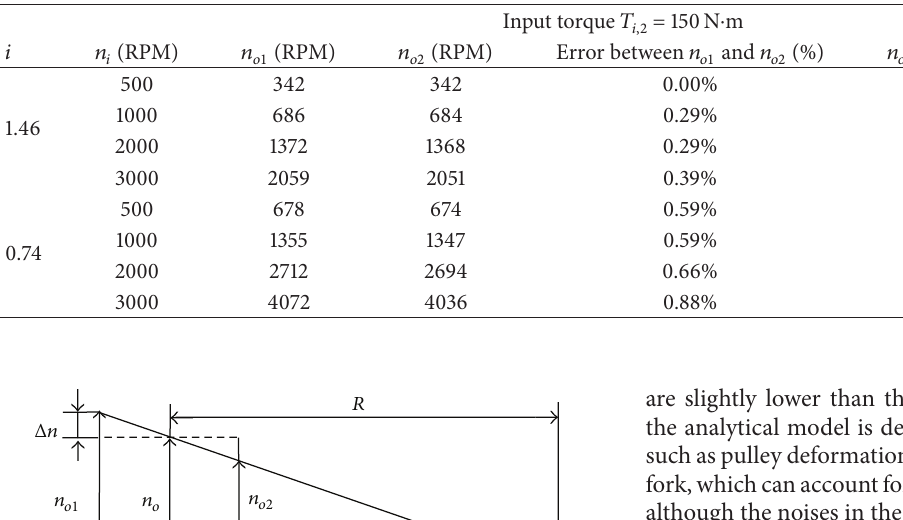
Table 3: Experimental results of inverse differential gearbox.